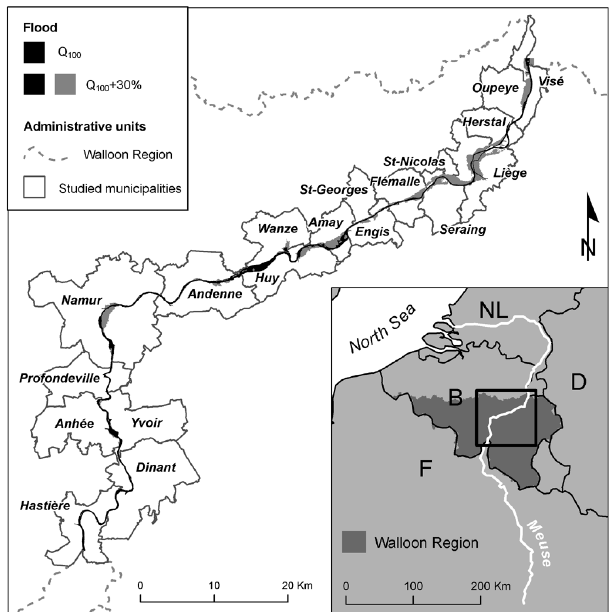
Fig. 2. Study area. Situation of the 19 studied municipalities in the river Meuse Basin and flooded area corresponding to two studied discharges ( Q 100 and Q 100 +